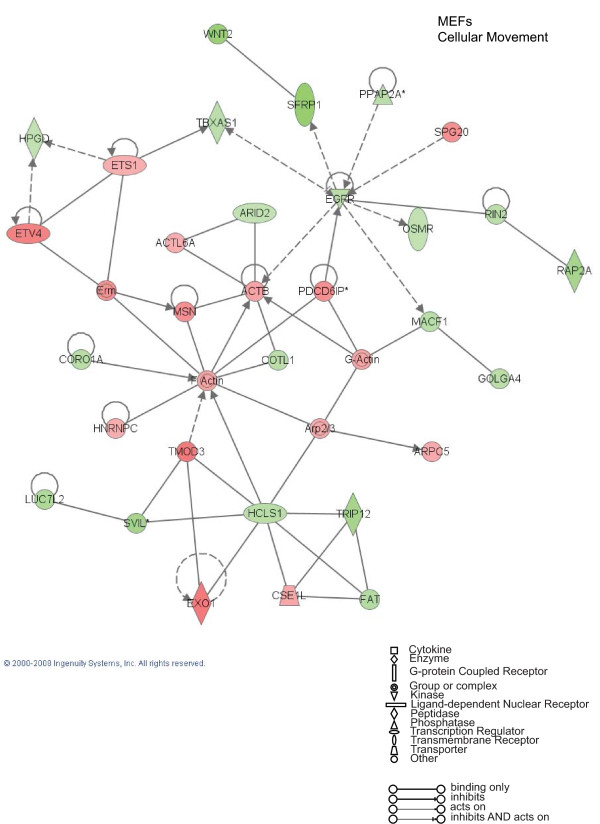
Cellular Movement: Ingenuity Pathway Analysis for mouse embryo fibroblasts (MEFs). Specific functional networks of the newly identified AP-2α-regulated genes were obtained using Ingenuity Pathway Analysis systems and "cellular movement" is one of the two main networks found. Gene products are represented as nodes and biological relationships between two nodes as a line. Continuous lines indicate direct interactions, while dashed lines represent indirect connections. Shapes of nodes symbolize functional classes of gene products (see the figure legend). The green and red symbols represent down- and up-regulation, respectively, while the white symbols indicate genes absent in the dataset but related with the dataset genes.